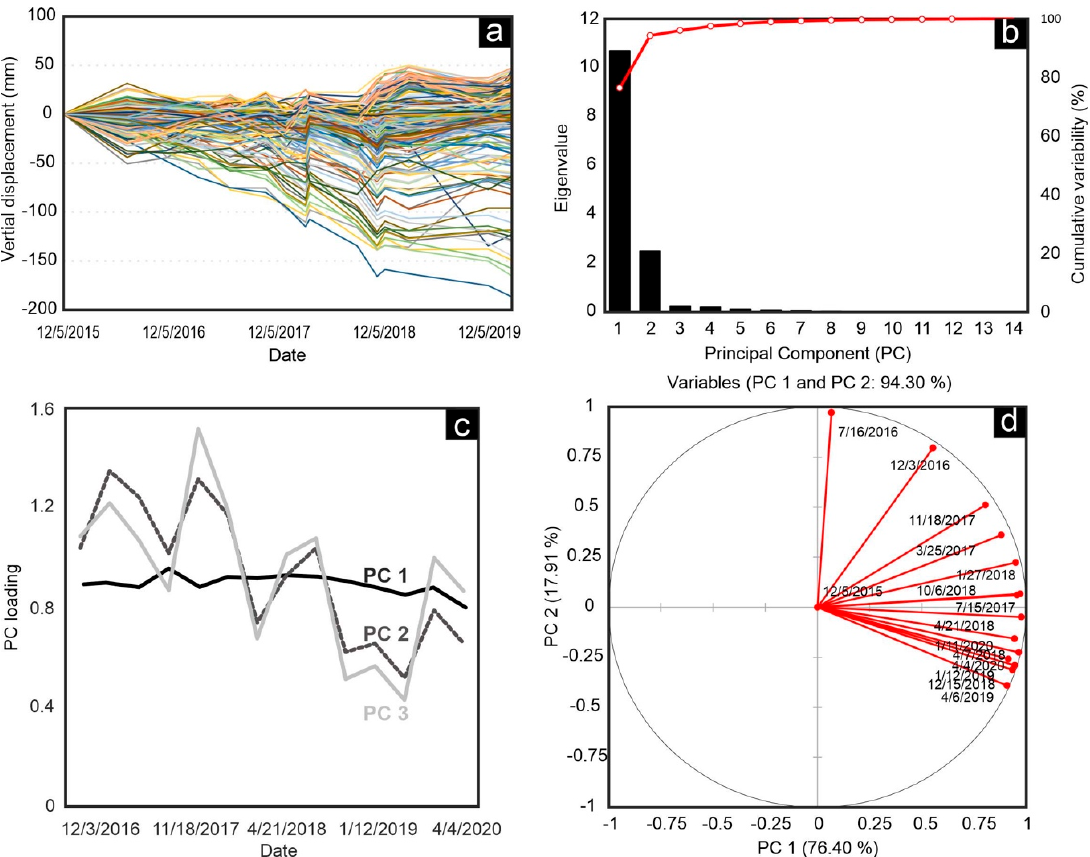
Figure 12. ( a ) SBAS time series of randomly selected points for PALSAR-2 dataset (only 250 points are shown), ( b ) scree plot of principal components (PCs), ( c ) three major components of principal component analysis (PCA), which explain about 96% of the variance, and ( d ) circle plot of variables for PC1 and PC2 loadings.